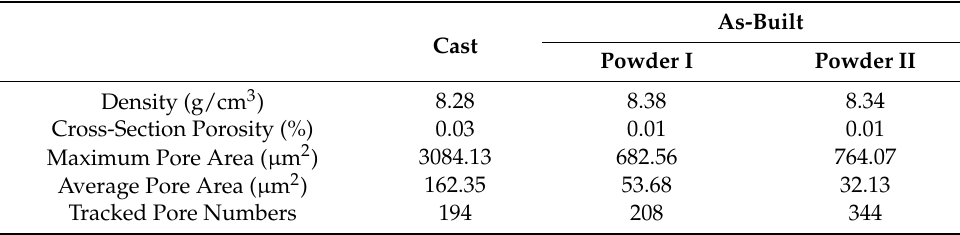
Table 1. The density of Powder I and Powder II corresponding to as-built and cast samples measured by gas pycnometer, and details of pore observation results on the sample cross-cut section: cross- sectional porosity, measured maximum pore area, average pore area, and tracked pore numbers.